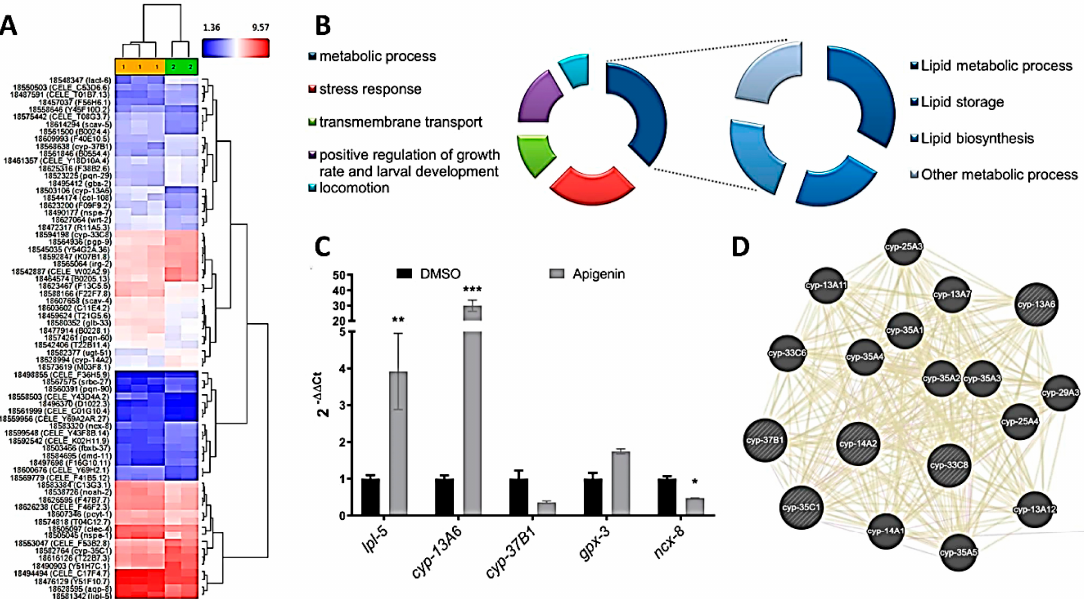
Figure 4. Gene expression microarray comparison of apigenin (100 µ M)-treated worms vs. DMSO control worms. ( A ) Hierarchical clustering analysis of apigenin (yellow) and DMSO (green) samples. ( B ) Gene Ontology biological processes enriched in apigenin-treated worms compared with DMSO control group. ( C ) qPCR analysis of genes di ff erentially expressed in microarray analyses. Results are expressed as the fold di ff erence expression levels of each gene in the apigenin-treated group compared with the DMSO control group, calculated with the 2 − ∆∆ Ct method. Significance refers to the e ff ect of resveratrol with respect to DMSO control worms (Wilcoxon test, * p < 0.05; ** p < 0.01; *** p < 0.001). ( D ) Interaction network obtained from GeneMANIA of the most related genes connected with cyp P450 observed after treatment with